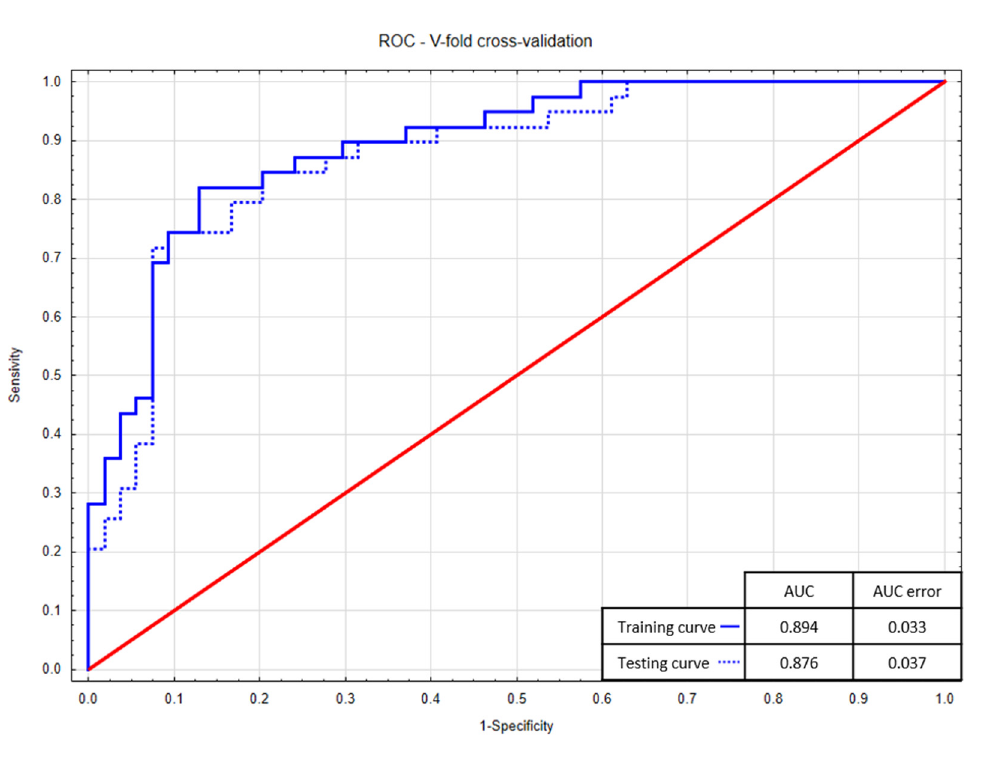
Figure 2. V-fold cross-validation—learning ROC curves for the logistic regression model including cleaning index.